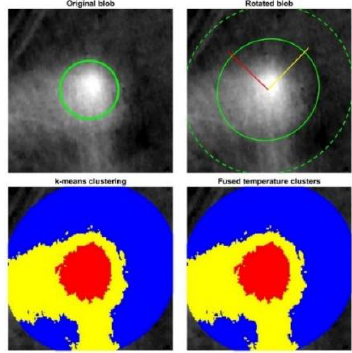
Figure 4 Anomaly detection without cluster